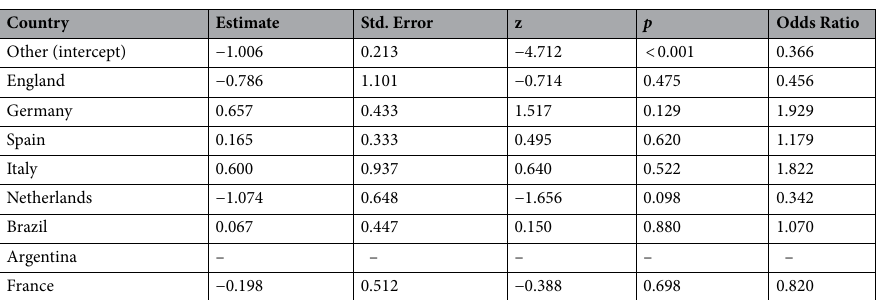
Table 3. Coefficients for the different nationalities in the binomial regression model for all kicks taken in penalty shootouts faced by goalkeepers during Champions League and Europa League matches (85 of 311 penalty kicks were missed against 48 different goalkeepers in the analyzed time periods). In the analyzed time periods, no penalty kicks were taken against Argentinian goalkeepers in penalty shootouts in the Champions and Europa